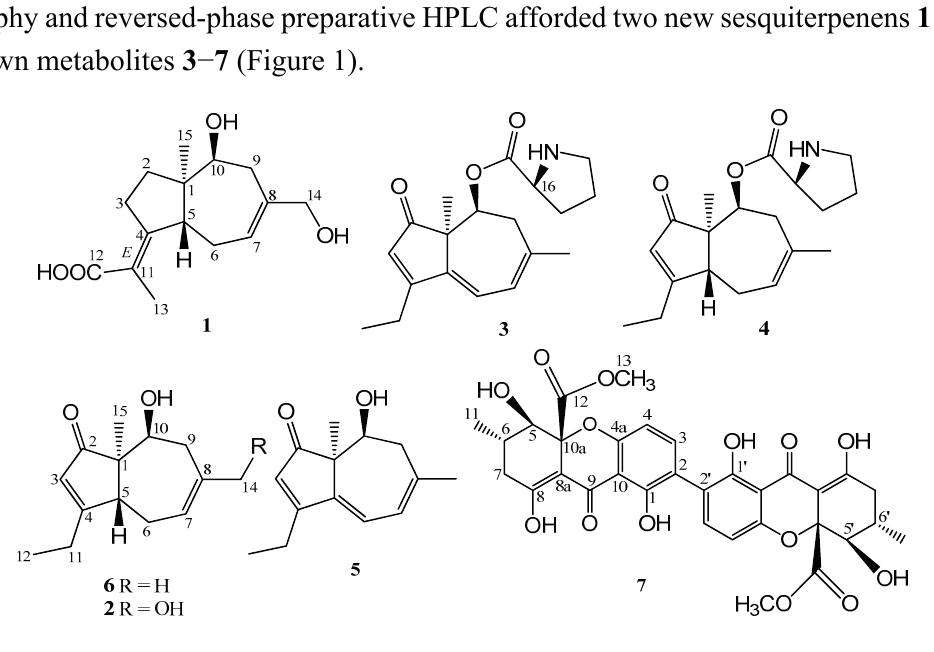
Figure 1. Chemical structures of compounds 1 – 7 from A. aculeatus